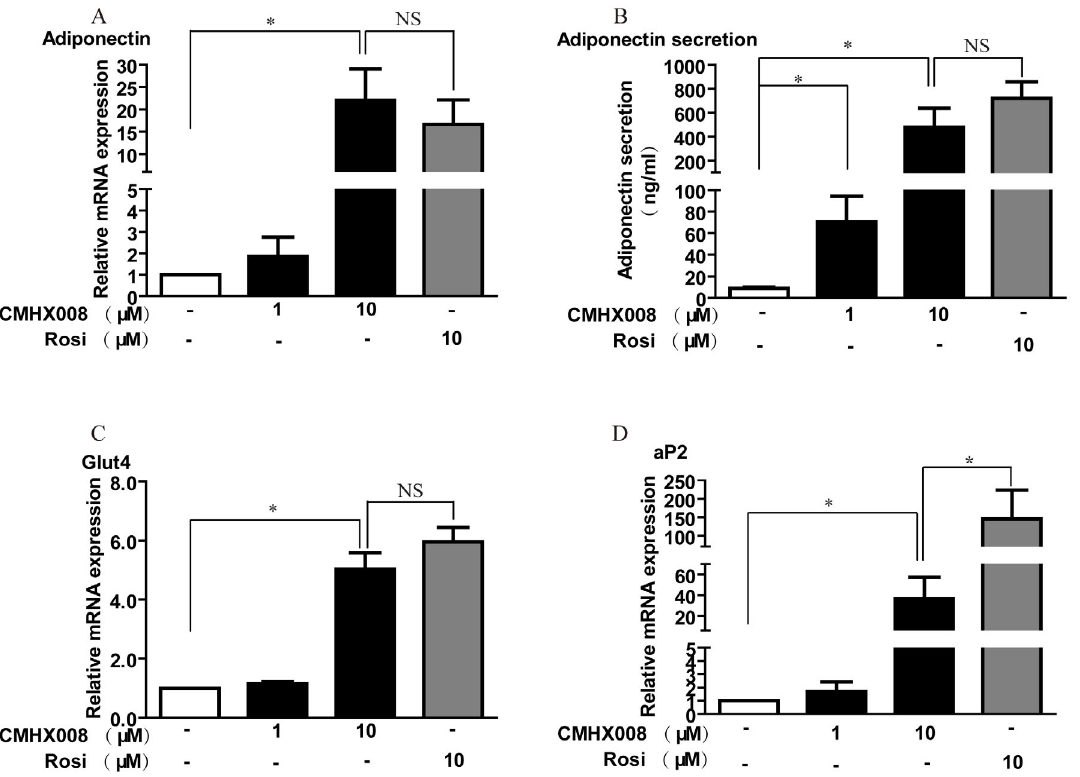
Figure 3. CMHX008 differentially regulates PPAR c target genes in 3T3-L1 adipocytes. Post-confluent 3T3-L1 preadipocytes were incubated in differentiation medium for 2 days. The medium was changed to DMEM containing insulin and 10% FBS for another two days and then replaced again with fresh DMEM containing 10% FBS for another 3 days. Rosiglitazone and CMHX008 were administered at the initiation of differentiation and with every medium change. At day 7, the differentiation cells were harvested for total RNA extraction and the mRNA expression of adiponectin (A), Glut4 (B) and aP2 (D) was analyzed by real-time PCR, and secreted adiponectin in the culture medium was measured using adiponectin ELISA kit (B). Data are the means 6 S.E.M. from six independent experiments. *: P , 0.05; NS: no significance.